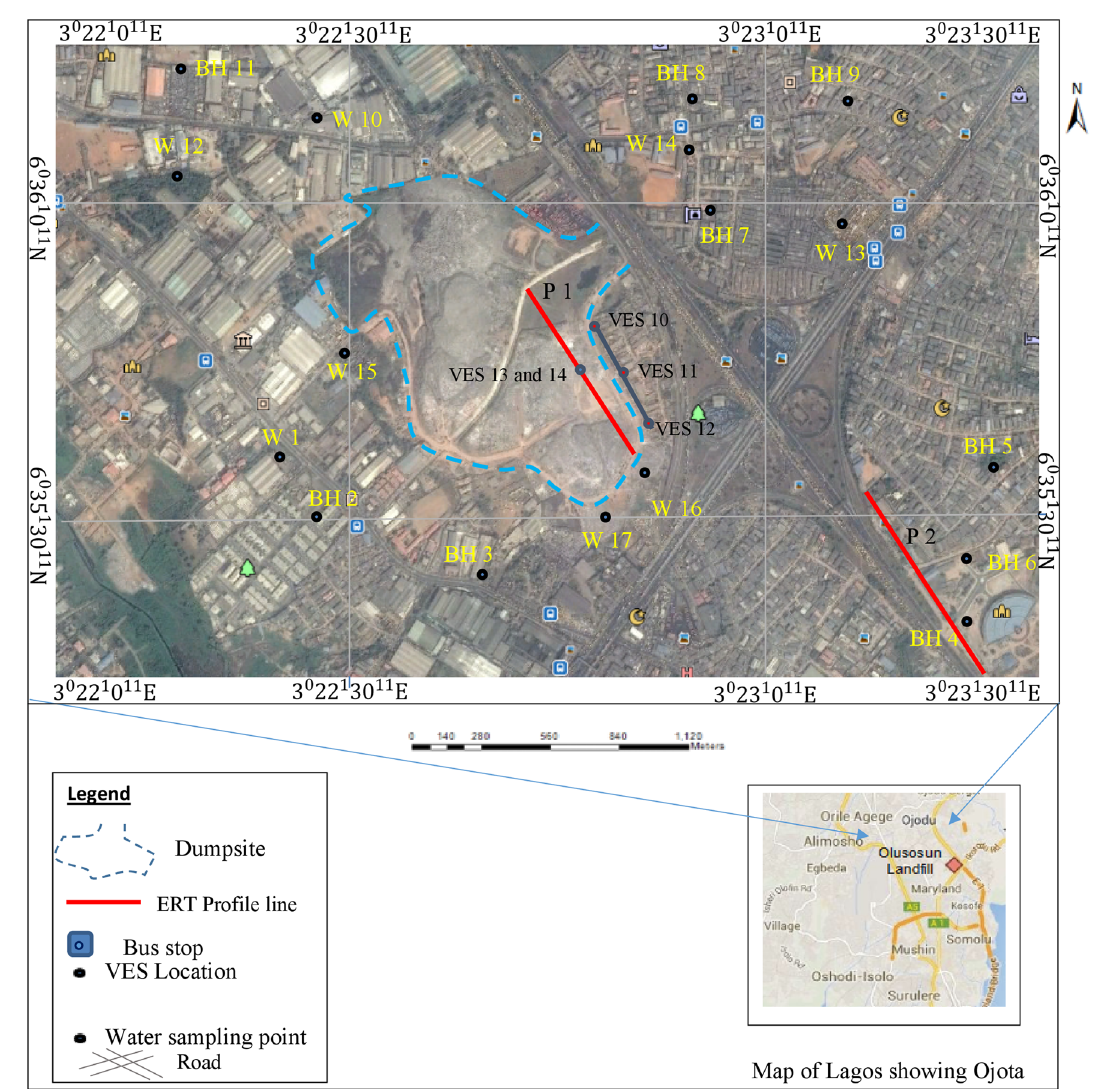
Fig. 2 Data acquisition map of the study